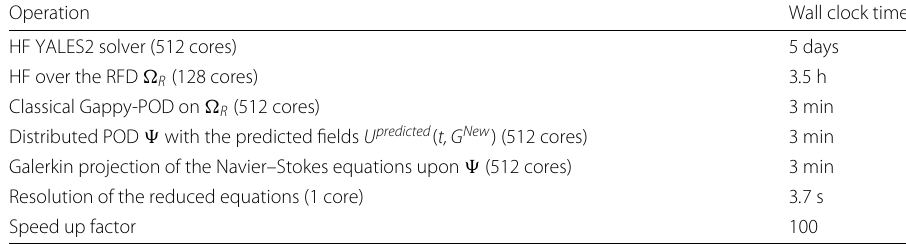
Table 3 Details of the computational costs Operation Wall clock